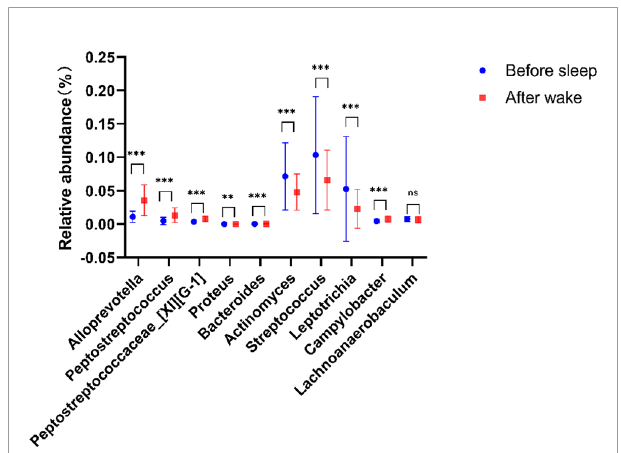
FIGURE 3 | Compared with tongue coating microbiota before sleep, fi ve genera were signi fi cantly enriched, while four genera were signi fi cantly reduced after waking up (**p < 0.01, ***p < 0.001, ns means p > 0.05).